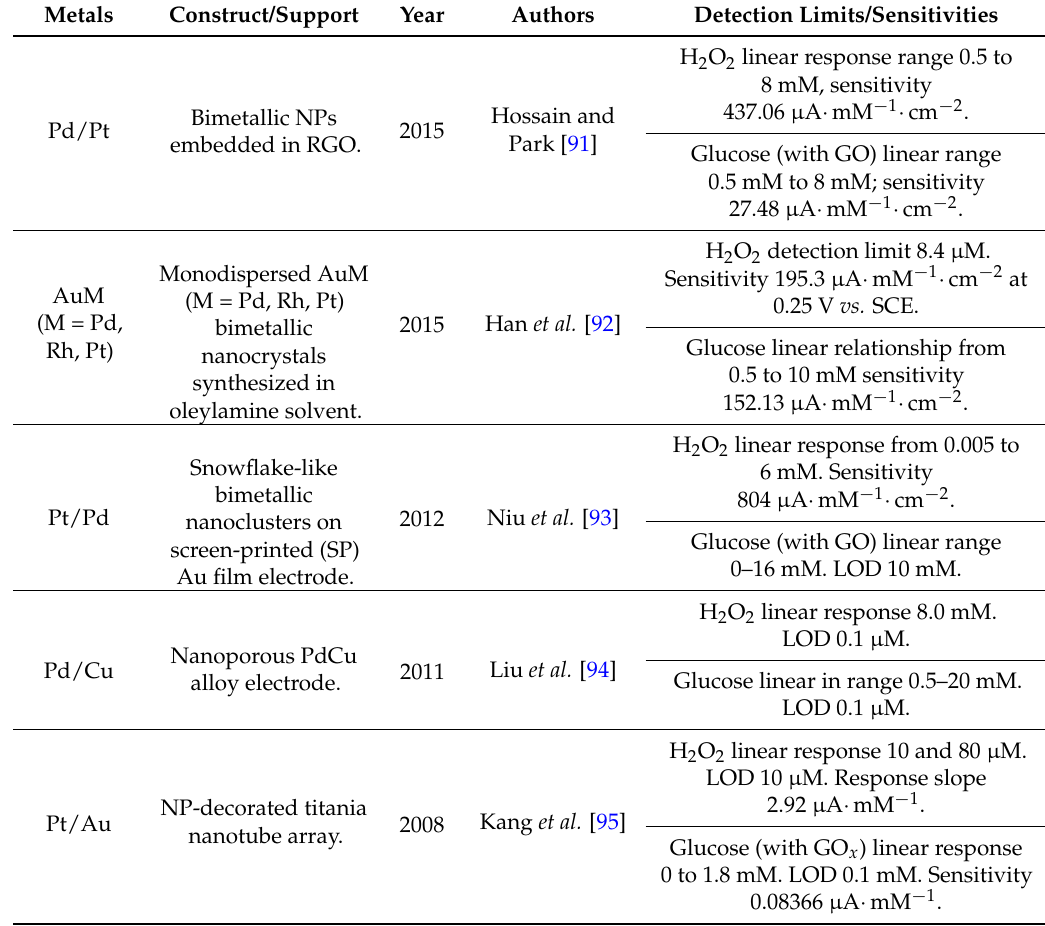
Table 3. Metals and constructs used for sensors designed jointly for H 2 O 2 and